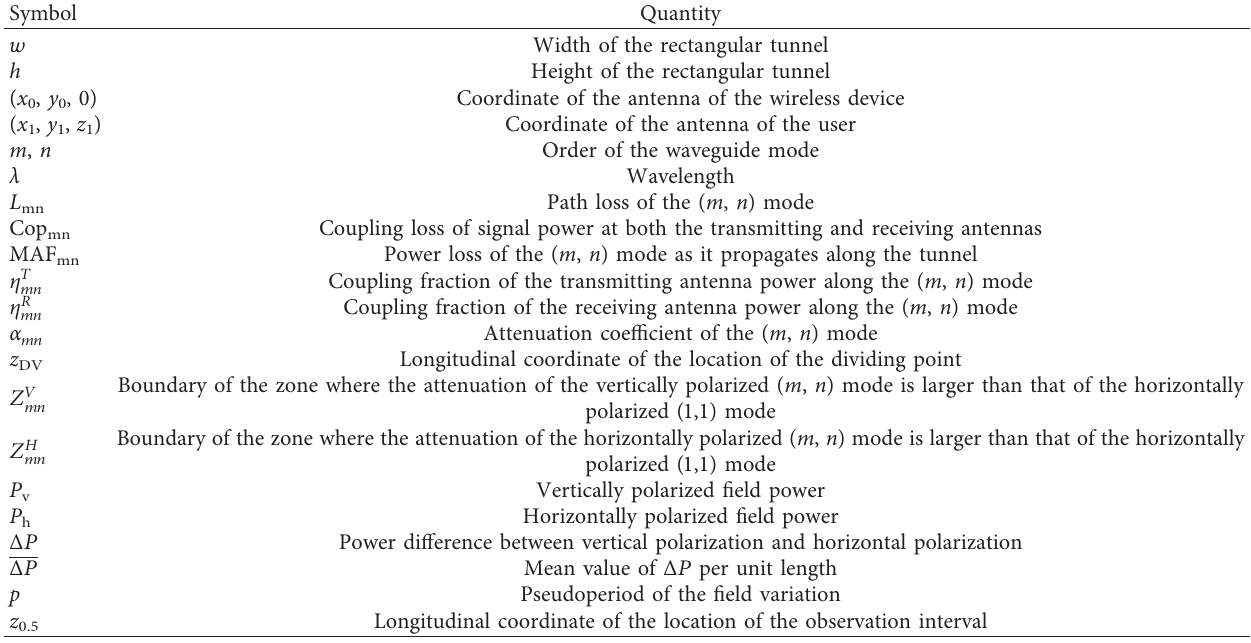
Figure 1: Procedure of coverage optimization for communication systems in underground tunnels. Table 2: List of symbols used in this